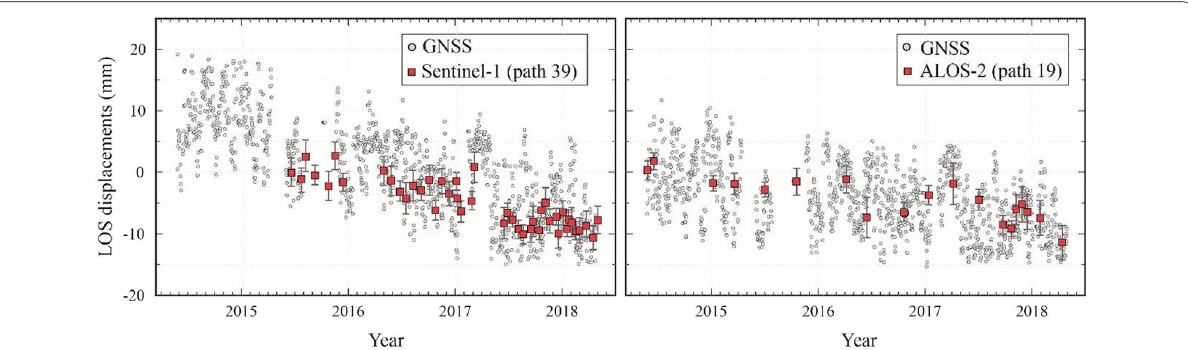
Fig. 11 Comparisons of displacement time series between InSAR measurements (red squares) and GNSS measurements (gray circles) at the KAHG GNSS site. The GNSS 3D displacement components are, respectively, projected into the LOS directions of a ascending Sentinel-1 (path 39), and b the descending ALOS-2 (path 19) for comparisons. Error bars indicate the estimated uncertainties of InSAR measurements similar to these in Fig.